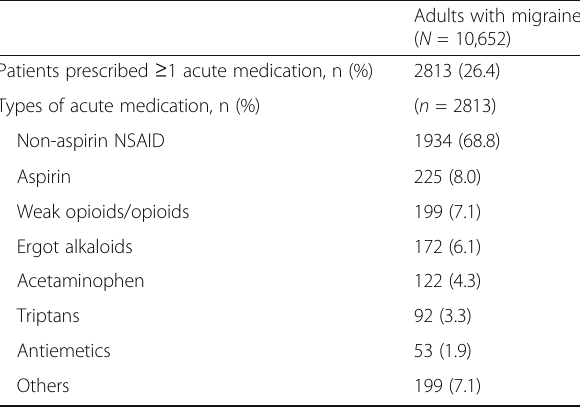
Table 1 Patient characteristics Table 2 Acute medication prescribed for migraine